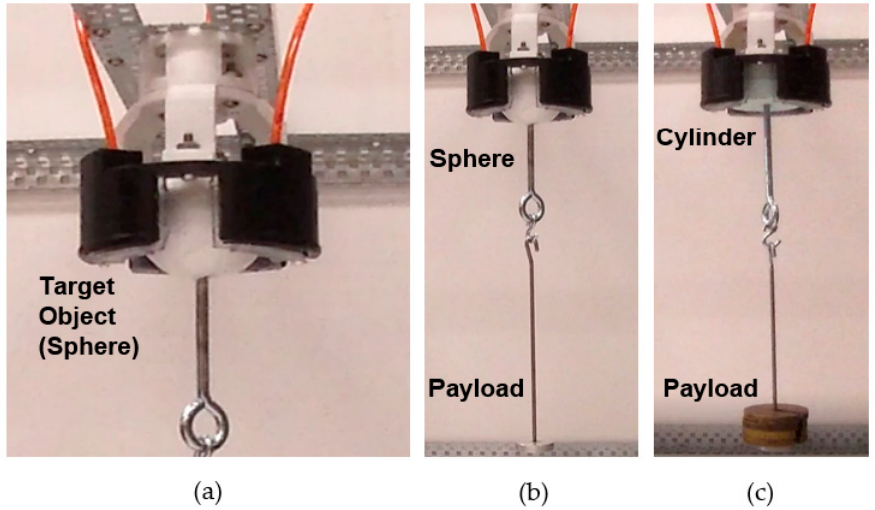
Figure 10. Experimental setup for payload tests. ( a ) Close-up of spherical target held in gripper; ( b ) sphere target for payload test; and ( c ) cylindrical target for payload test.